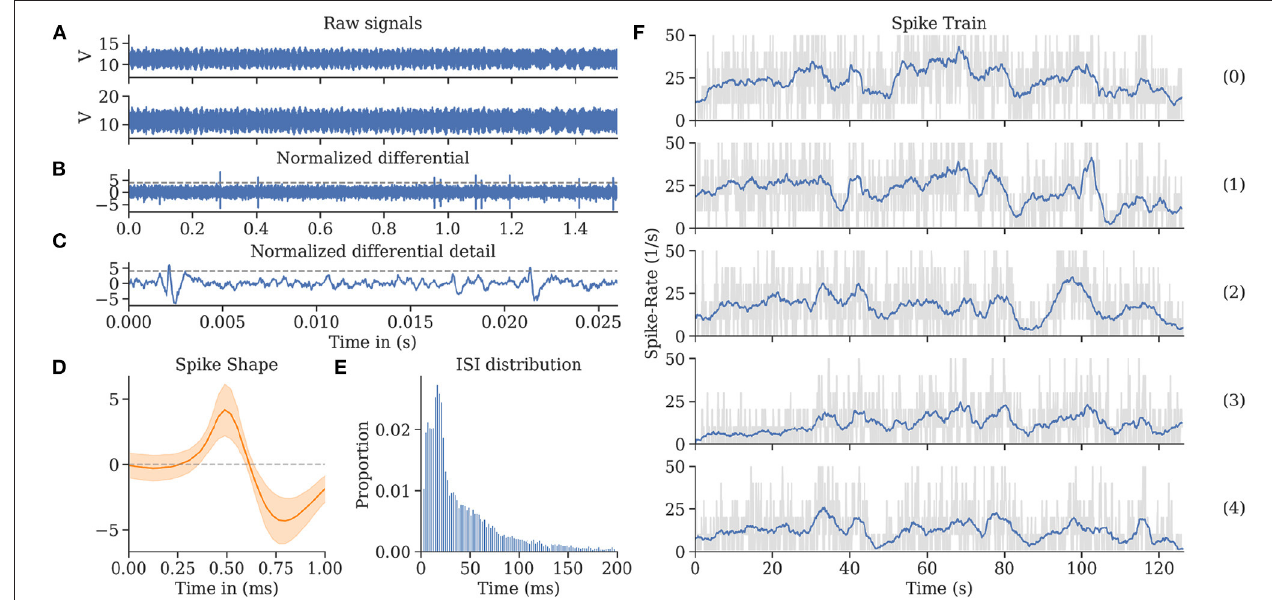
FIGURE 8 | Spike train evaluations for bee A. (A) The neuronal activity recorded during a flight from two channels exhibited high noise levels, most of which was eliminated by subtracting the two channels in the digital domain. (B) The differential raw trace shows spikes above residual noise. (C) Recording from (B) zoomed in on two individual spikes (exceeding the horizontal threshold potential). The recording was spike sorted to extract single-unit activity. (D) Spike shape template of units shown in (C) . (E) Inter-spike interval (ISI) distribution showing a single mode at 21 ms and very few instances below 5 ms. (F) Spike rate over time per flight (see Figure 4 ). Each graph represents a repetition of a continuous flight path from start to finish for the same trefoil trajectory. The repetitions share similar features synchronized to the time (and therefore place) of the flown path.